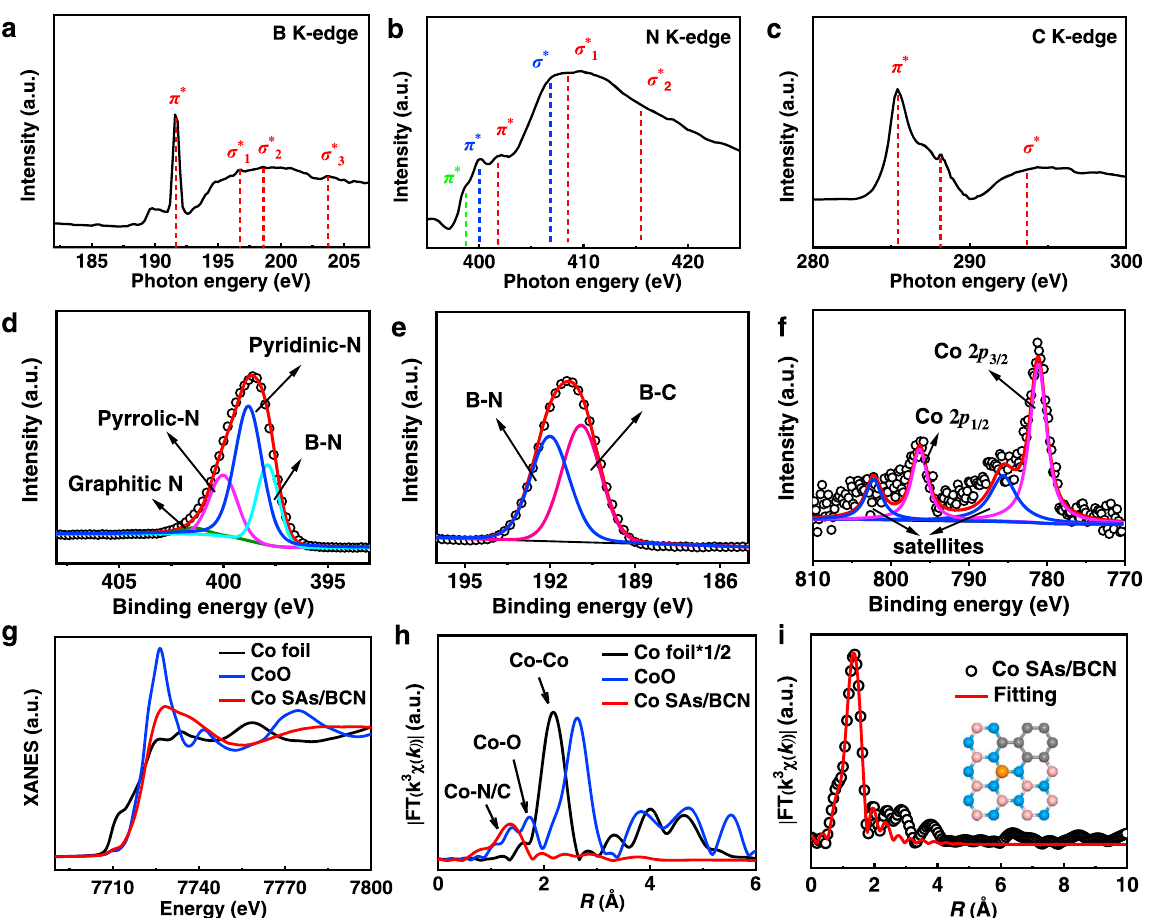
Fig. 3 Chemical state and coordination information for Co SAs/BCN. a B K -edge, b N K -edge, and c C K -edge XANES spectra of Co SAs/BCN. d – f High- resolution XPS of N 1 s ( d ), B 1 s ( e ), and Co 2 p ( f ) for Co SAs/BCN sample. g XANES spectra, h Fourier transform (FT) at the Co K -edge of Co SAs/BCN, CoO, and Co foil. i Corresponding EXAFS fi tting curves of Co SAs/BCN at R space. The inset of i is the schematic model of Co SAs/BCN, Co (orange), N (blue), B (pink), and C